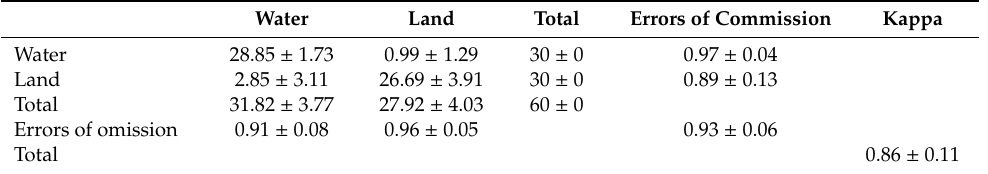
Table 1. Confusion Matrix showing the accuracy assessment results for the classified imagery. The values correspond to the mean ± the standard deviation of the classified imagery.